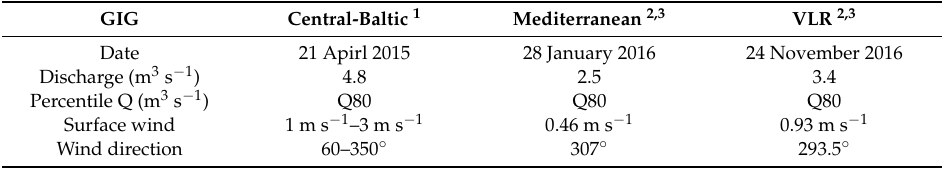
Table 4. Description of weather and reach characteristics during the flight at each of the Geographical Intercalibration Groups (GIGs) study sites. Weather conditions at the Central-Baltic reach were estimated based on the Shawbury (Shropshire, UK) meteorological aerodrome report. Similar information was obtained from the Agroclimatic Information for Irrigation Service weather stations at Motilleja (Albacete, Spain) and X á tiva (Valencia, Spain) for the Mediterranean and Very Large Rivers (VLR) GIGs reaches, respectively. Q stands for flow. 1 [43], 2 [44], 3